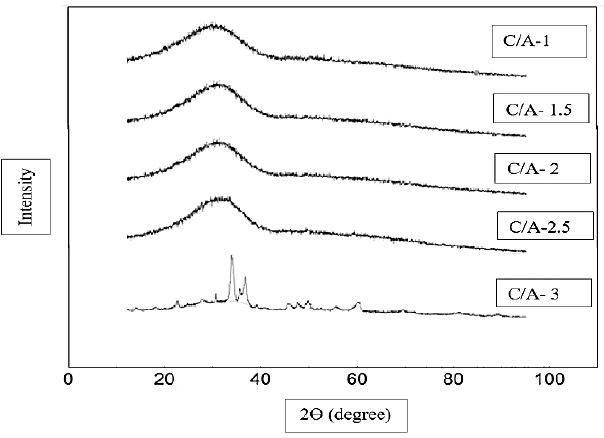
Figure 9. The XRD patterns of C-series mould powders with different C/A ratio.